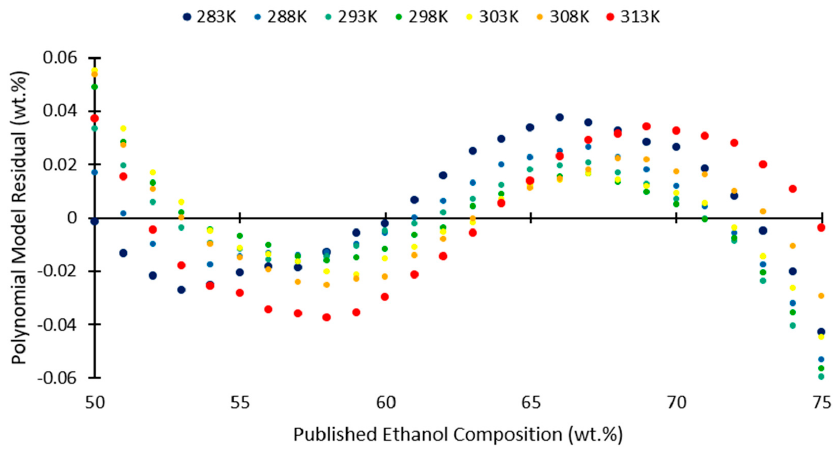
Figure 4. Weight percent (wt.%) residuals for mixture composition calculated using the polynomial expansion model with coefficients regressed using temperature dependent density data between 50–75 wt.% ethanol.